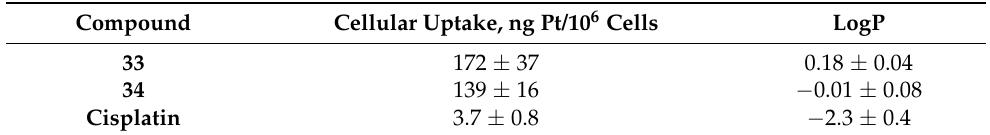
Table 19. Cellular uptake in LNCaP cells preincubated with 10 µ M of prodrugs 33, 34 and cisplatin for 6 hours and their corresponding logP